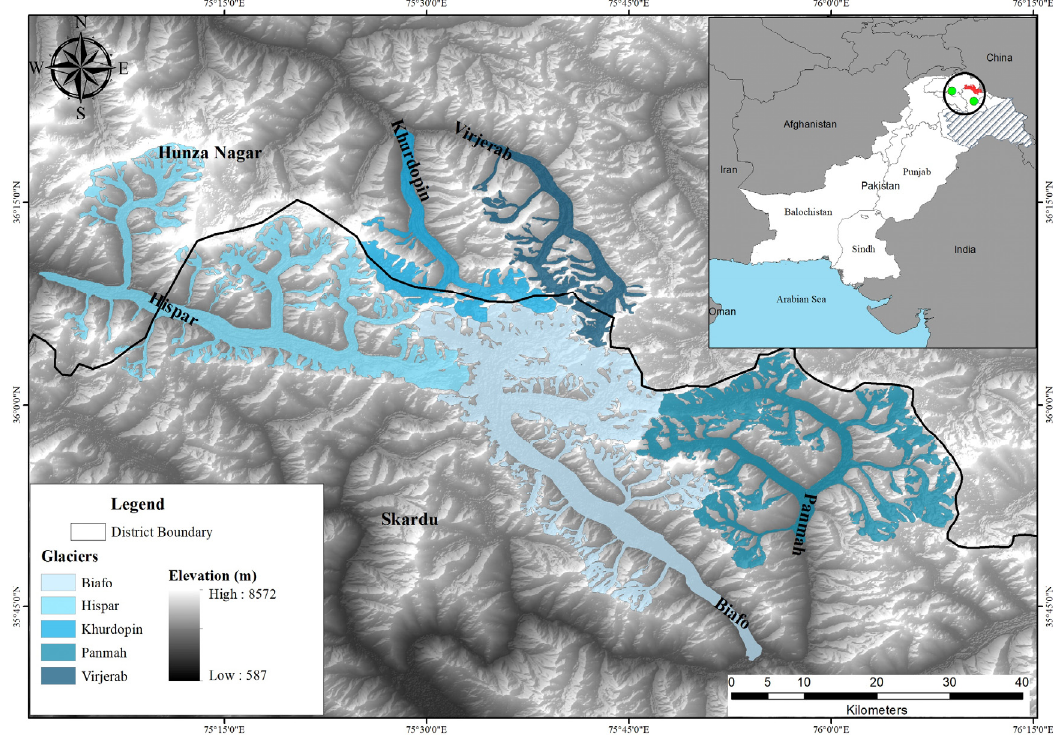
Figure 1. Location map of the Central Karakoram National Park (CKNP) in Gilgit Baltistan. Glacier boundaries are shown on ASTER 30-m GDEM. The red color boundary inside the encircled area shows the studied area and green dots show the location of Gilgit and Skardu meteorological stations in Gilgit Baltistan.